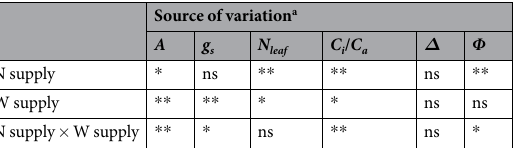
Table 1. Statistical significance of photosynthetic rate ( A ), stomatal conductance ( g s ), leaf nitrogen content ( N leaf ), the ratio of intercellular to ambient CO 2 concentration ( C i / C a ), carbon isotope discrimination ( Δ ), and bundle sheath leakiness ( Ф ) in Cleistogenes squarrosa responses to N and water (W) supply in the pot experiment. a * , ** , and ns for P < 0.05, P < 0.01, and not significant,